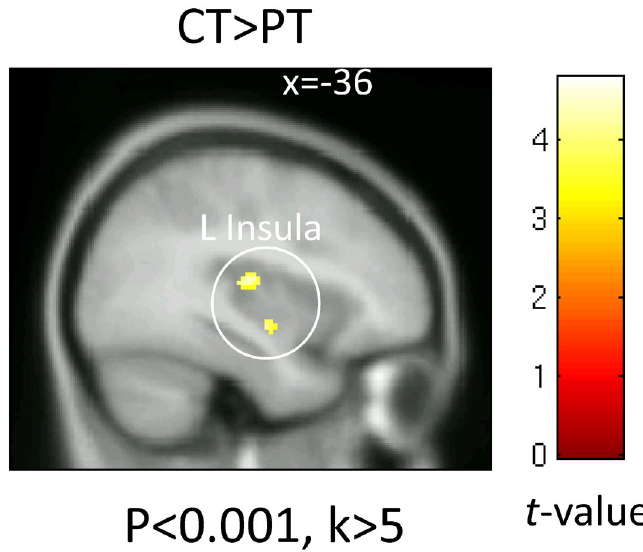
Figure 2. Brain activity in response to the non-conscious presentation of fear. The map shows a significantly greater activation in response to non-conscious fearful face stimuli in the healthy control than the insomnia patient group. Significant differences were observed in the left insula. Significant clusters are rendered on a T1 anatomical referential image displayed in neurological convention, with the left side corresponding to the left hemisphere.